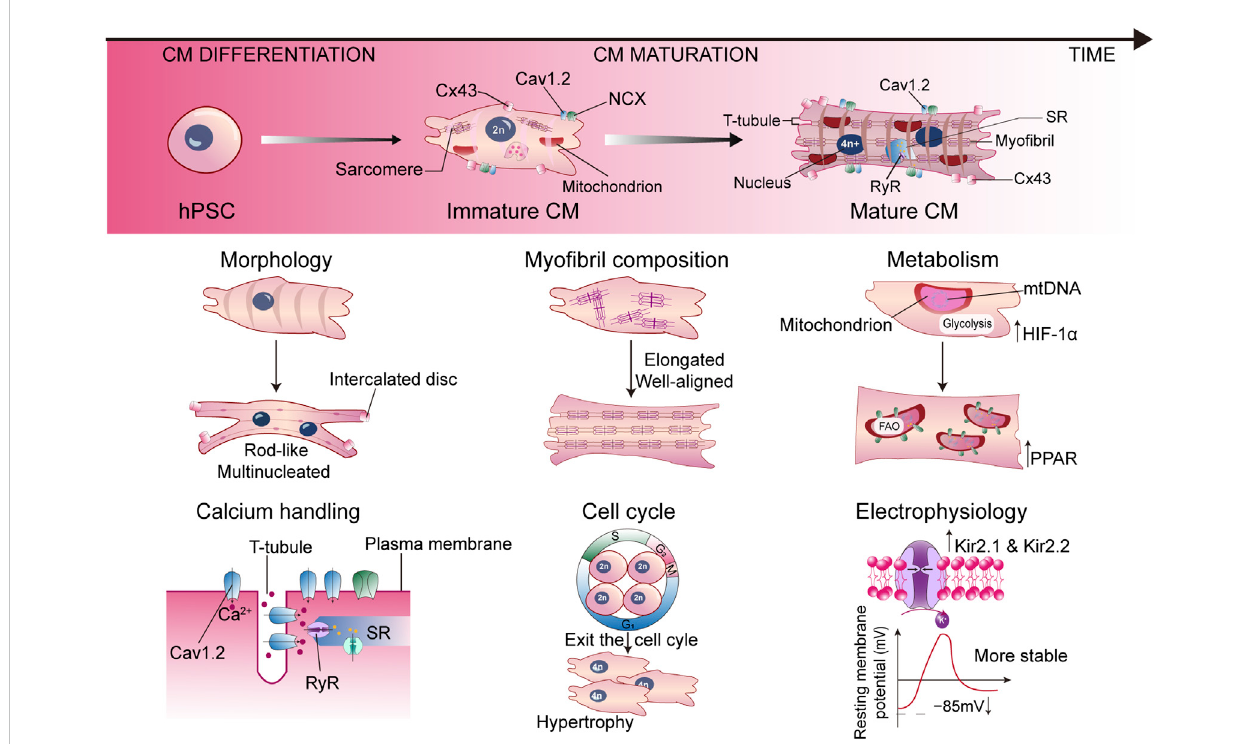
FIGURE 1 Representative hallmarks for characterizing the mature SC-CM. Cav1.2, L-type Ca 2+ channel; CM, cardiomyocyte; Cx43, connexin43; HIF-1 α , hypoxia inducible factor 1 α ; hPSC, human pluripotent stem cell; NCX, Na + /Ca 2+ exchanger; PPAR, peroxisome proliferator-activated receptor; RyR, ryanodine receptor; SR, sarcoplasmic